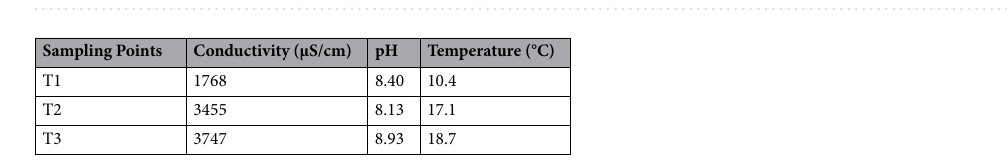
The elemental composition was consistent with the mineralogical profile (Fig. 2b and Supplementary Table). For T1, the allochthonous proportion increased from the upper to the bottom layer, indicating increased Al, Si, and Ca. This trend was associated with the trend of increasing plagioclases with depth. The presence of ortho- clase provided K. Additionally, Fe was likely detected from ferric oxides, indicating a high correlation with the occurrence of plagioclases. Therefore, the detrital origin of the sediment triggered an increase in Al, Si, Ca, K,